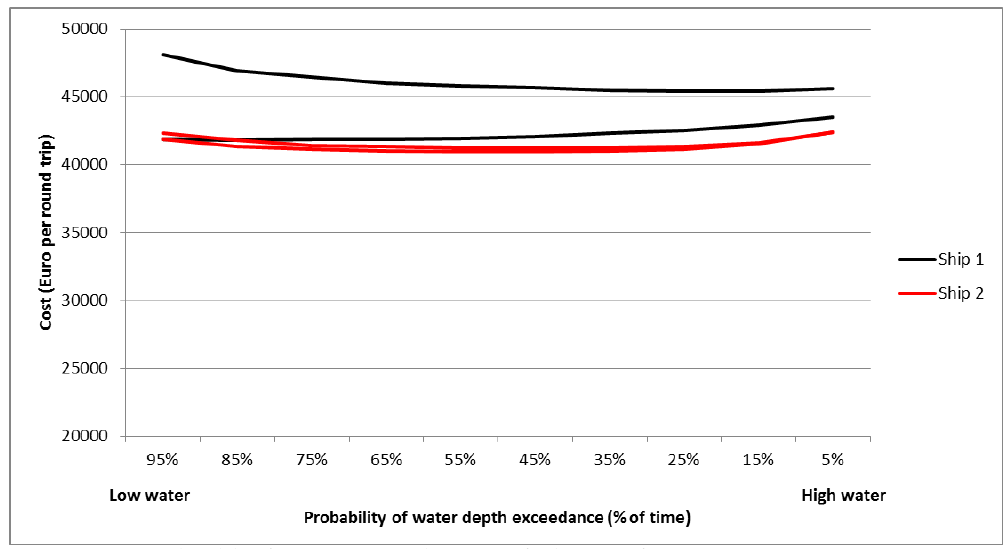
Figure 11. Bandwidth of cost per roundtrip at a fuel price of 600 Euro/ton Note: this figure does not take variance in fuel prices into